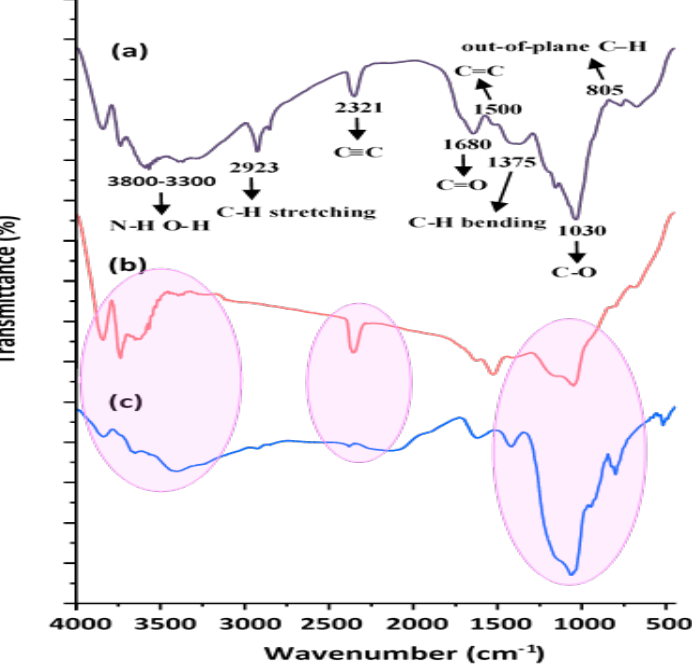
Molecules 2022 , 27 , x FOR PEER REVIEW Figure 3. FTIR spectra of (a) MSMP, (b) MSMPAC, and (c) MSMPAC-MB. Figure 3. FTIR spectra of ( a ) MSMP, ( b ) MSMPAC, and ( c ) MSMPAC-MB.